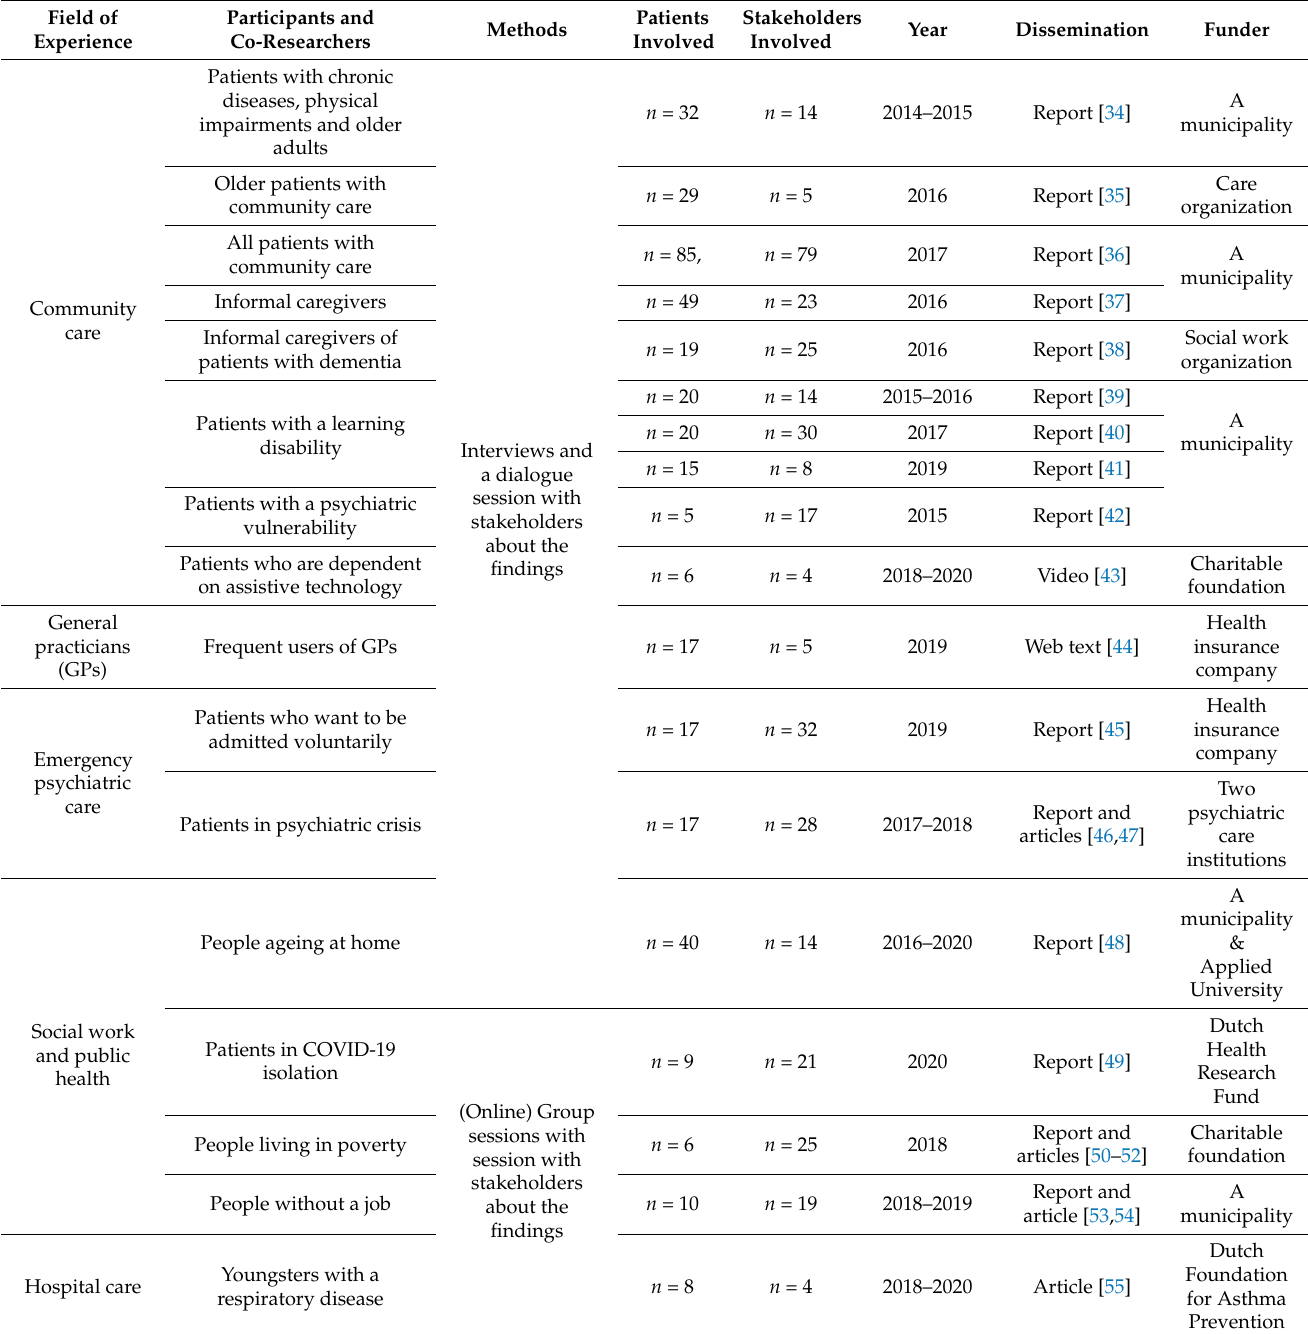
Table 1. The background of the 18